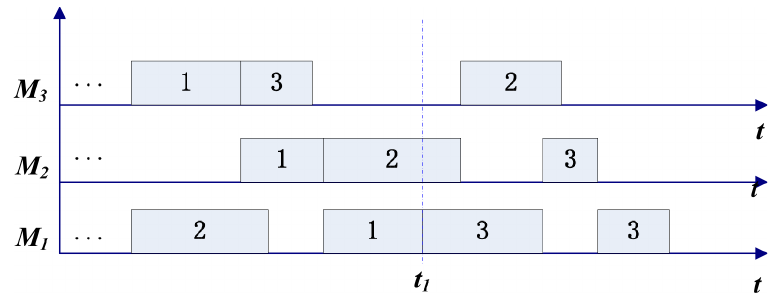
Figure 3. An illustration of the schedule of one sub-problem S